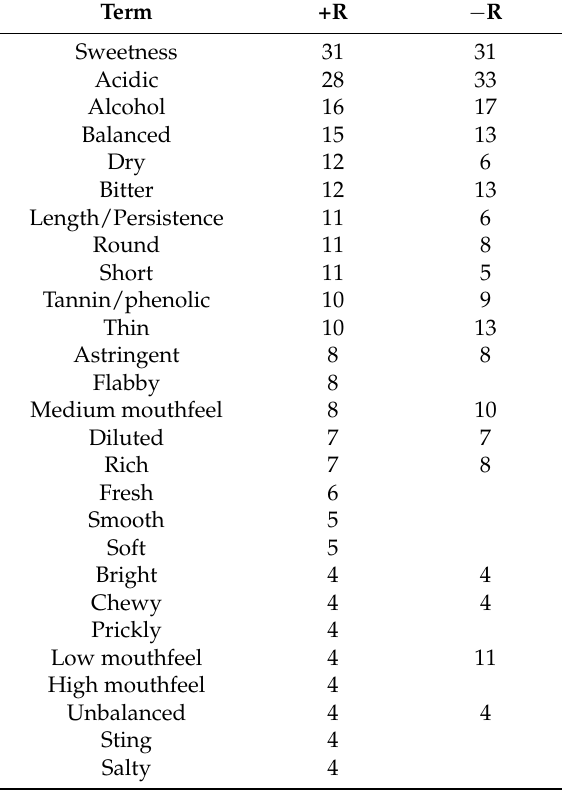
Table 1. Frequency of mouthfeel descriptors used for UFP with retronasal aroma (+R) and without retronasal aroma ( ´